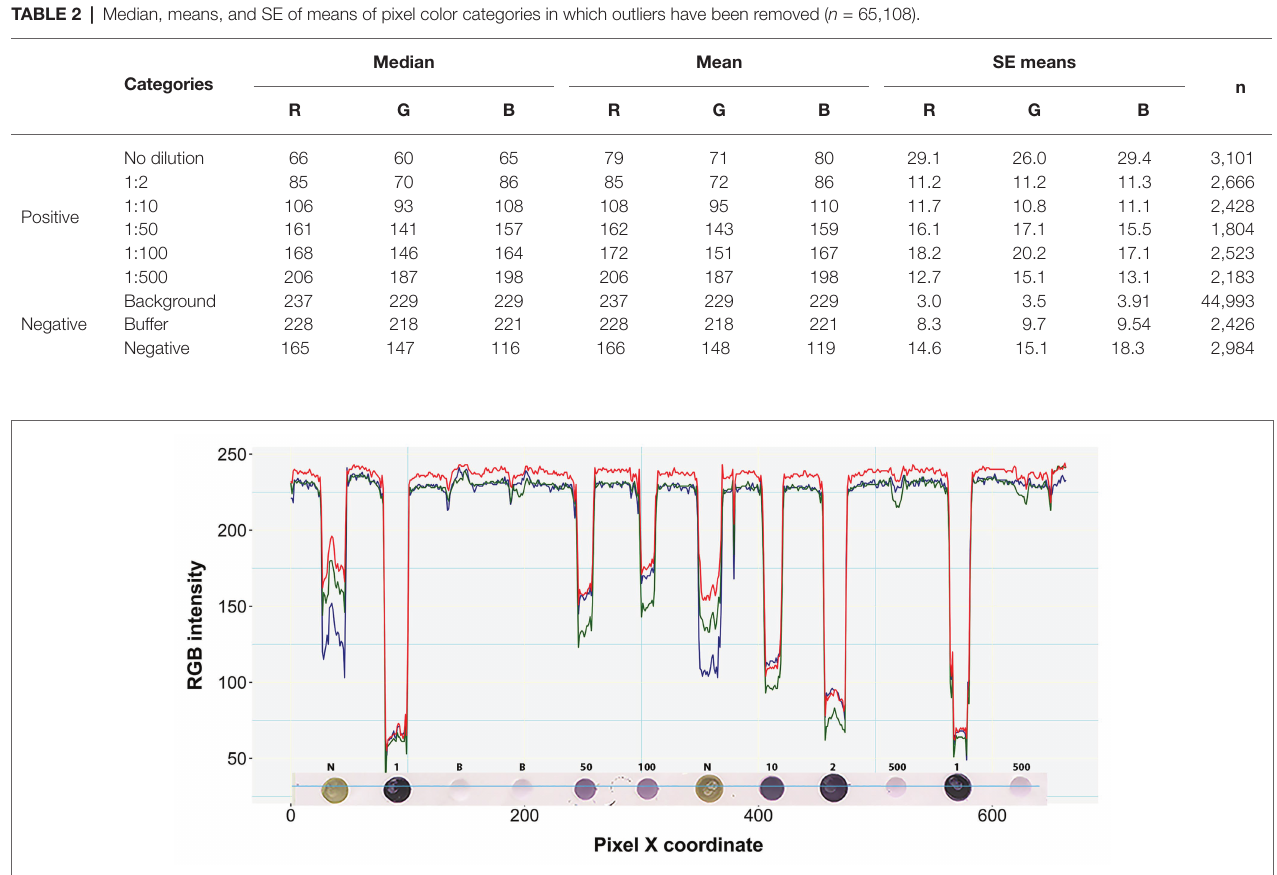
FIGURE 4 | RGB pixel intensity vs. dot coloration patterns in a perceived one pixel-wide line. A four pixel-wide line (~6 pixels per mm) is actually shown here traversing the fourth row of the prototypic blot image at a representative point of the Y-axis ( Y = 204). Each dot on the blot is a raster or bitmap image of ~200 pixels. Numbers above the dots denote the undiluted status (1) or dilution factor of positive samples. N and B denote negative and buffer controls, respectively.